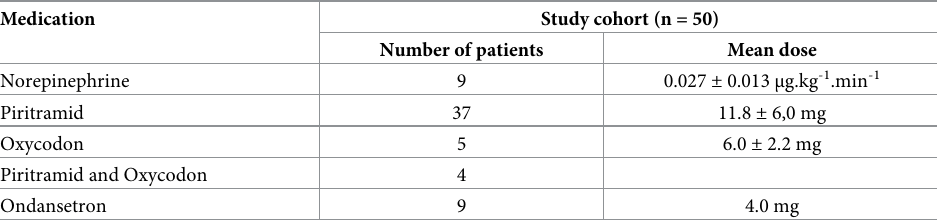
Table 3. Postoperative medication in the